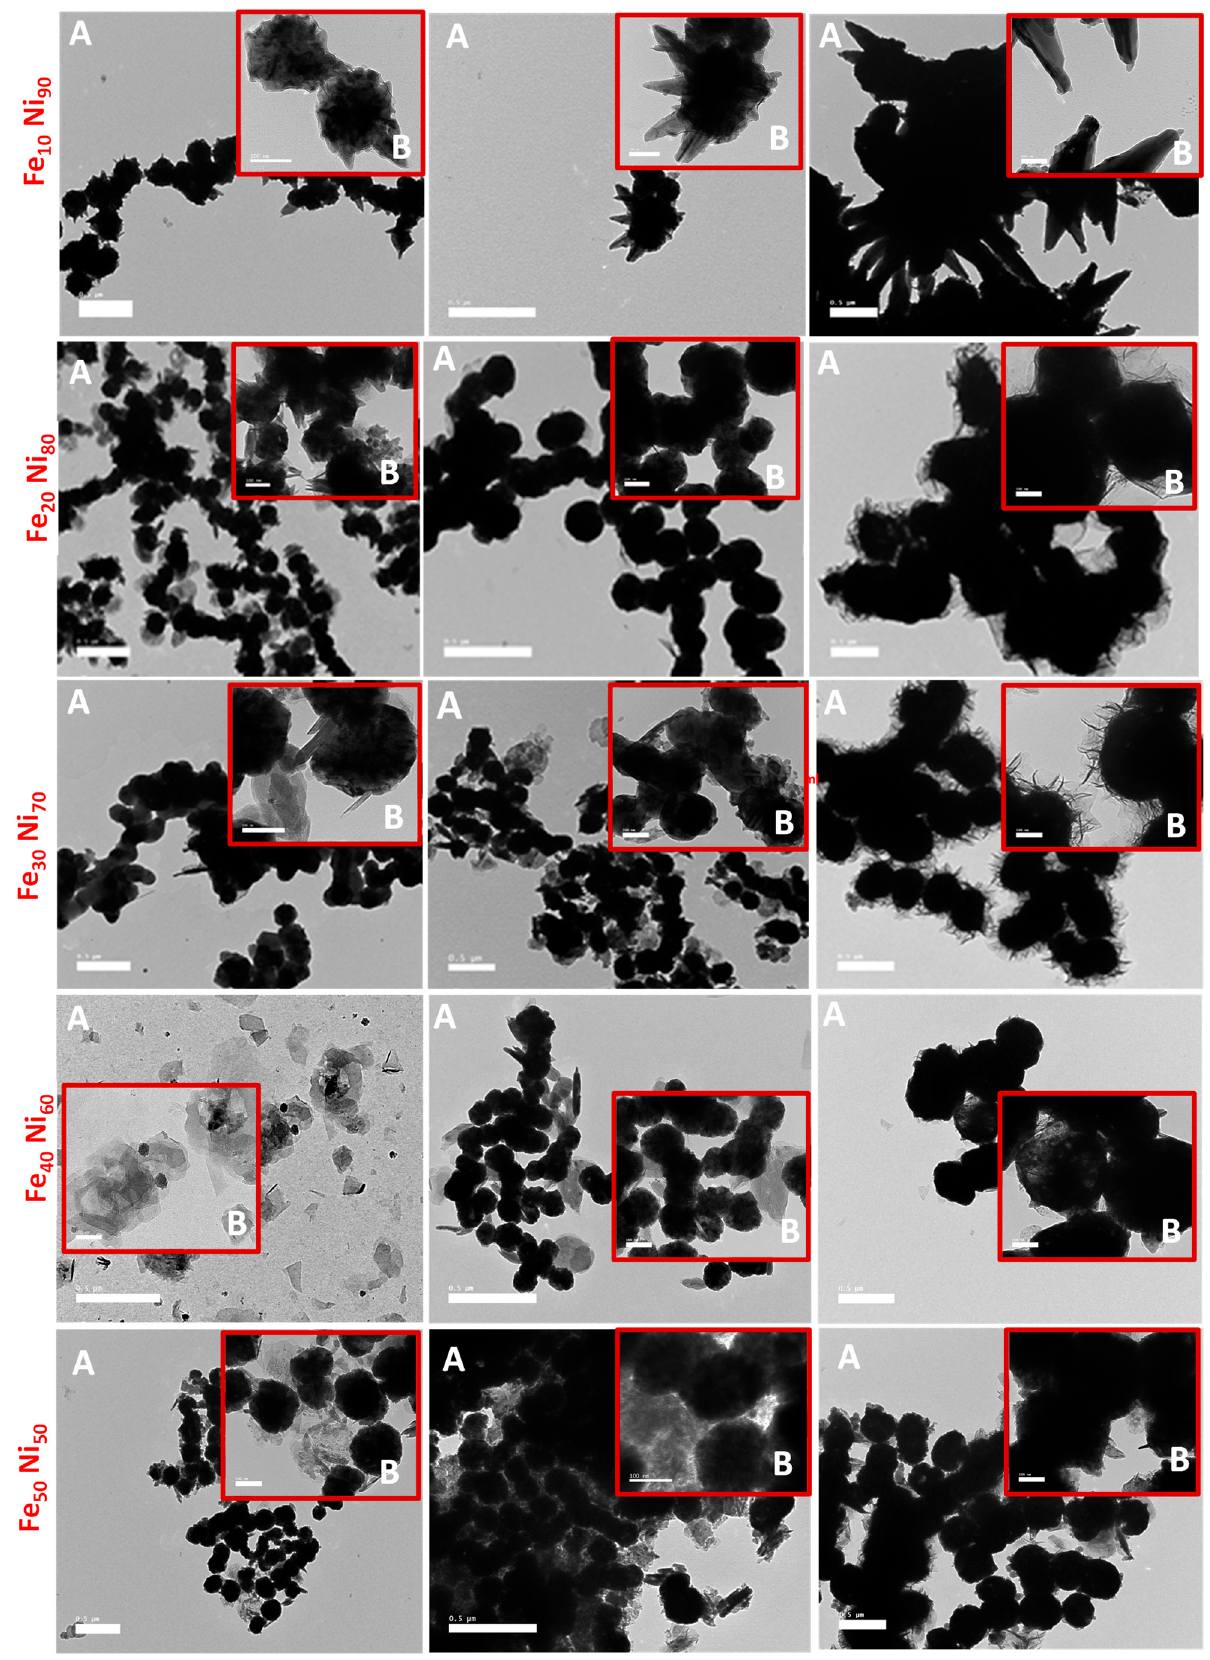
Figure 3. TEM images of the prepared iron-nickel alloy at two magnifications; ( A ) ×5000 and ( B ) ×15,000.